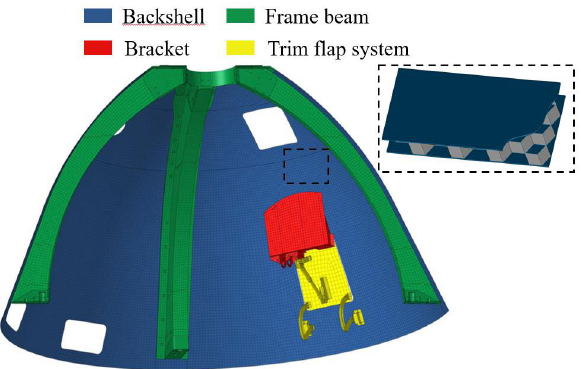
Figure 14. FE model of the trim flap system installed on the backshell.